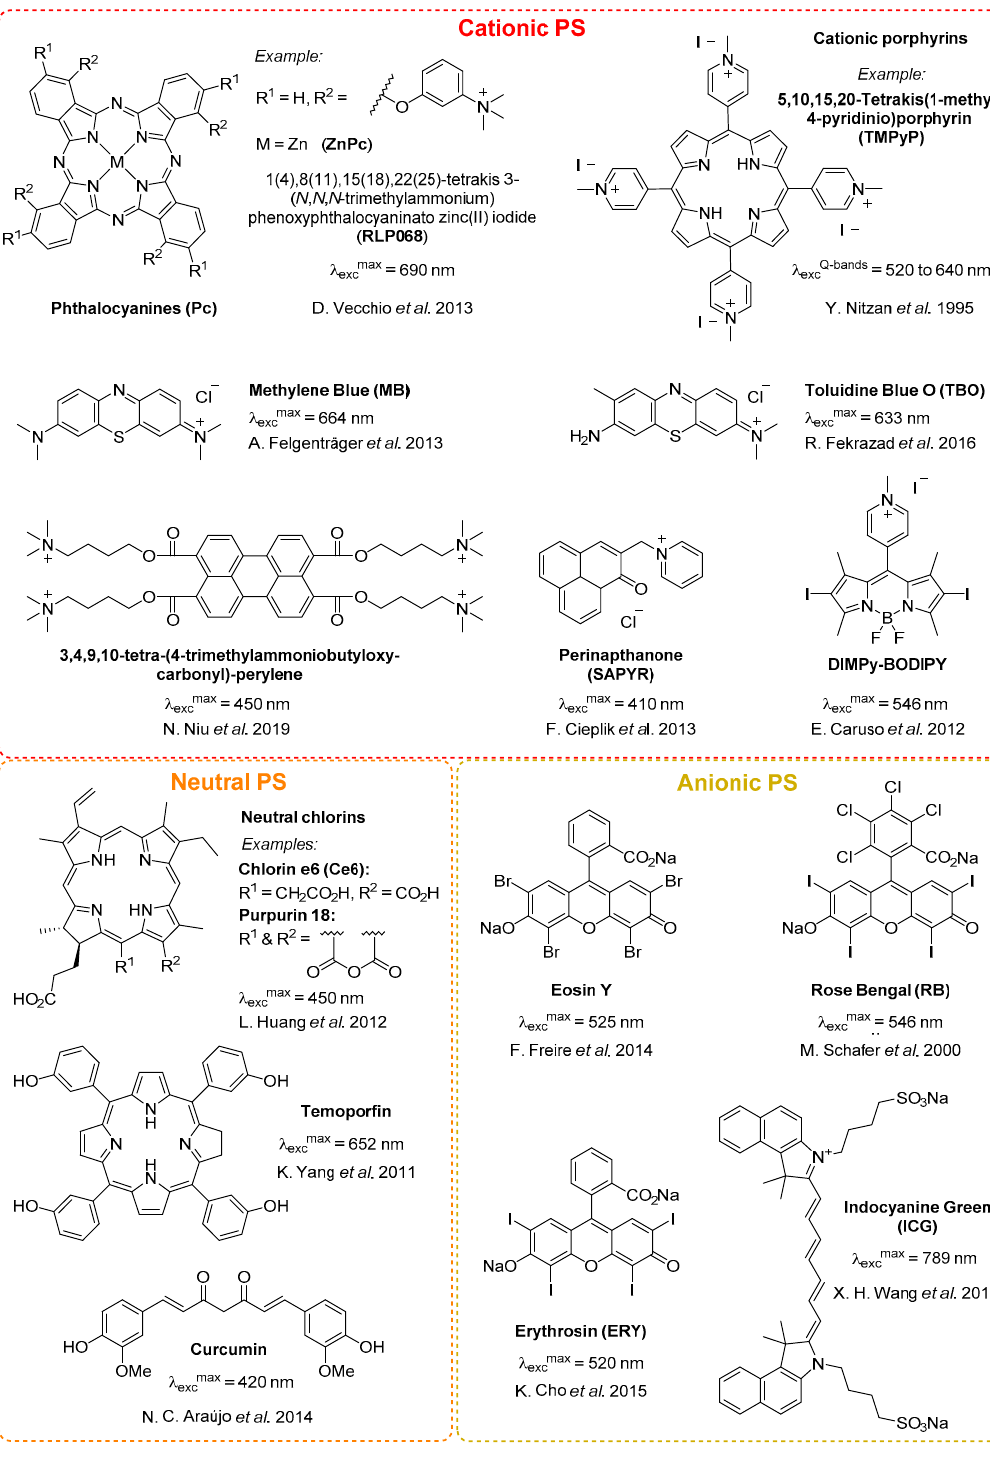
Figure 2. Selected examples of common cationic, neutral and anionic PS used in aPDT.